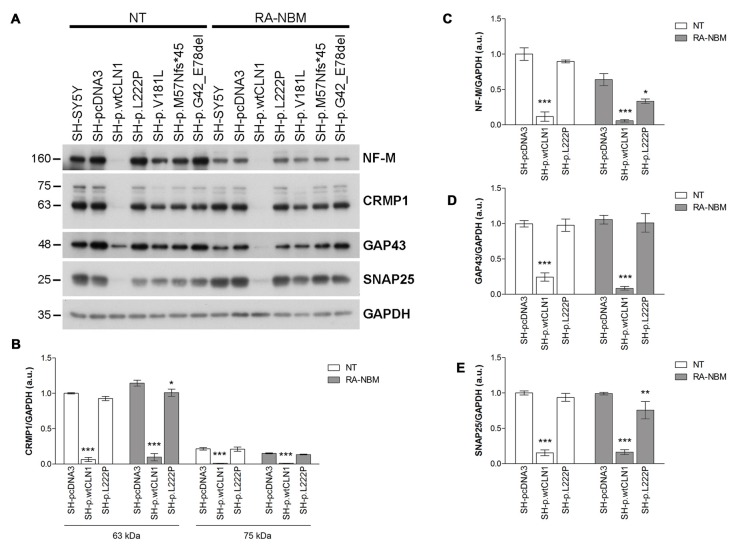
Immunoblotting analysis of selected DEGs identified in SH p.wtCLN1 cells and encoding for palmitoylated proteins. (A) Representative WB of proteins coded by four down-regulated genes (NF-M, CRMP1, GAP43 and SNAP25), identified in SH p.wtCLN1 transcriptomic profile. A strong decrease in protein expression was evident in SH-p.wtCLN1 cellular lysates, in comparison to no visible effect in other cell lines. (B–E) Semi-quantitative WB analysis of the same proteins confirmed highly decreased expression of these markers in SH-p.wtCLN1 cells, both under basal condition and following differentiation in RA-NBM medium. A slight down-regulation in expression of a short 60 kDa isoform of CRMP1 (isoform 2), NF-M and SNAP25 following RA-NBM differentiation was detected in SH-p.L222p lysates whereas no significant change in GAP43 expression was observed in the same cell line. GAPDH served as internal standard; a.u. arbitrary units; mean ± SEM of three independent experiments; Two-way ANOVA followed by Bonferroni’s post-test; *p < 0.05, **p < 0.01, ***p < 0.001.